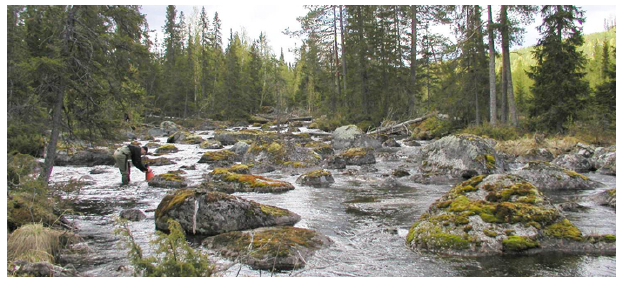
Fig. 5 .Section of the Baksjöbäcken stream in